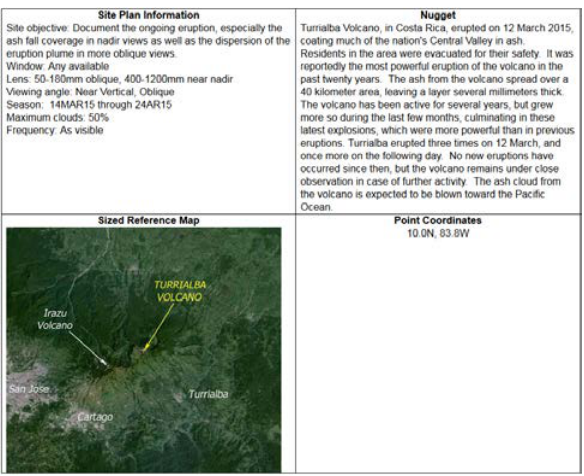
Figure 6. Example of IDC targeting “nugget” for an eruption of Turrialba Volcano in Costa